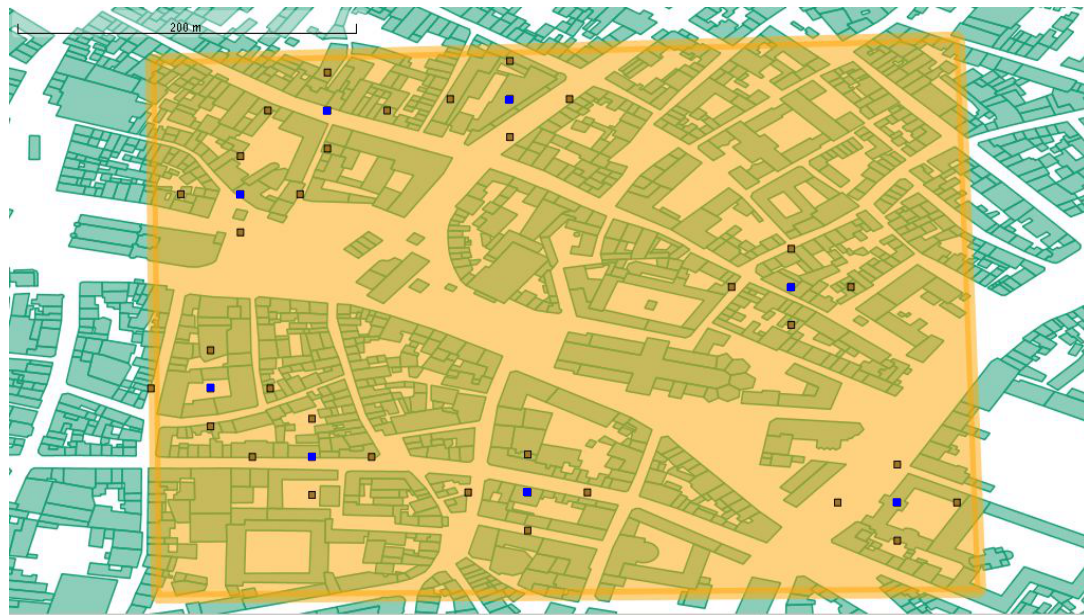
Figure 1. The considered suburban area of 0.3 km 2 (orange box) of the city center of Ghent, in Belgium, with macrocell base stations (blue points) and microcell base stations (orange